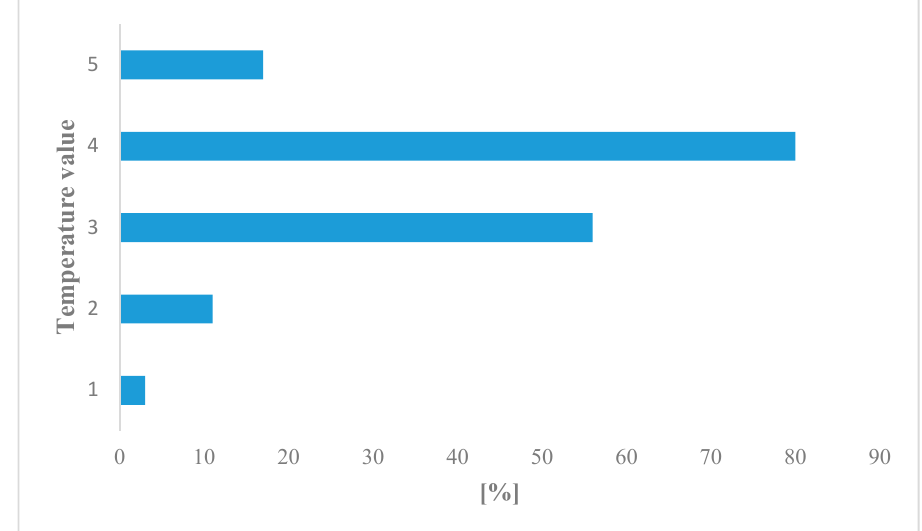
Figure 4. Percentage share of plant life forms in the Niwka postmining area: (H) hemicryptophyte; (M) megaphanerophyte, (N) nanophanerophyte, (T) therophyte; (G) geophytes; (Ch) chamaephytes; (Hy) hydrophytes; (C) herbaceous chamaephyte, (li) liana, and (pp) semiparasite.